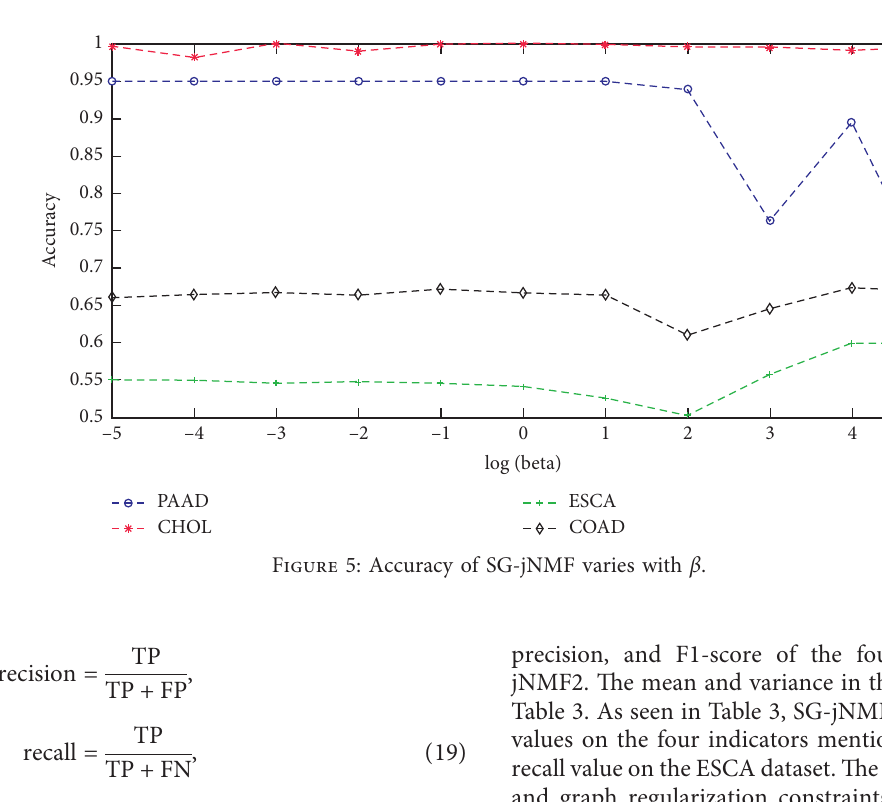
Figure 5: Accuracy of SG-jNMF varies with β